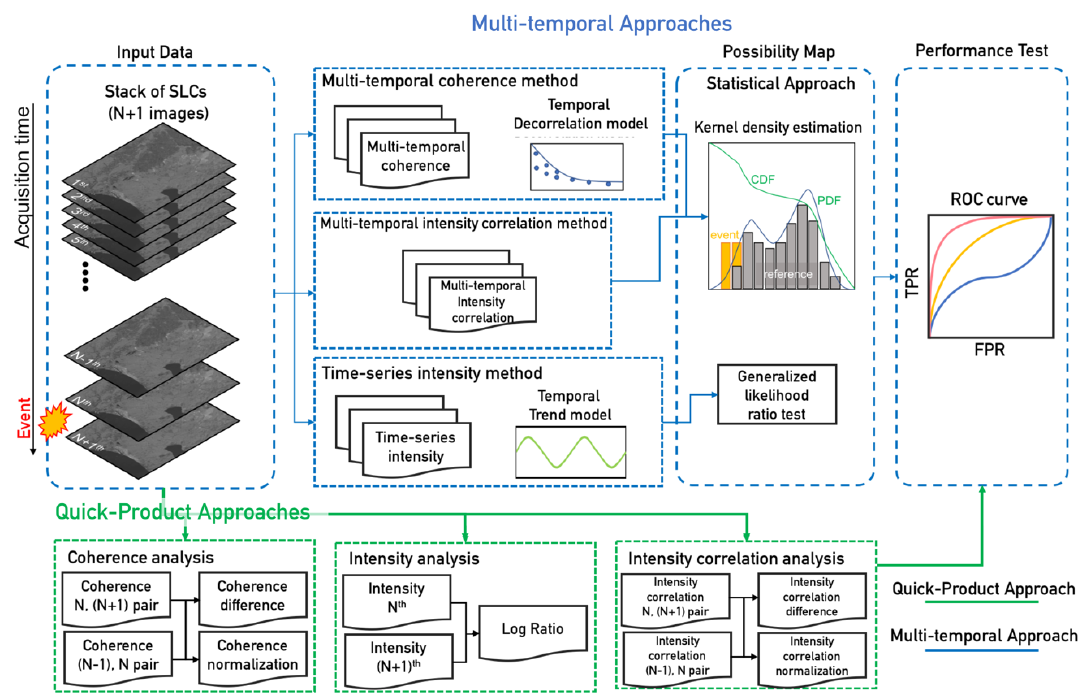
Figure 2. Workflows of quick-product and multi-temporal approaches. Here, a disaster event occurs between N th and (N + 1) th acquisition time. Quick products (green lines) include the coherence difference, coherence normalized difference, log-ratio of intensity, intensity correlation difference, and normalized difference of intensity correlation. The multi-temporal approach (bule lines) includes the multi-temporal coherence method, multi-temporal intensity correlation method, and time-series intensity method.